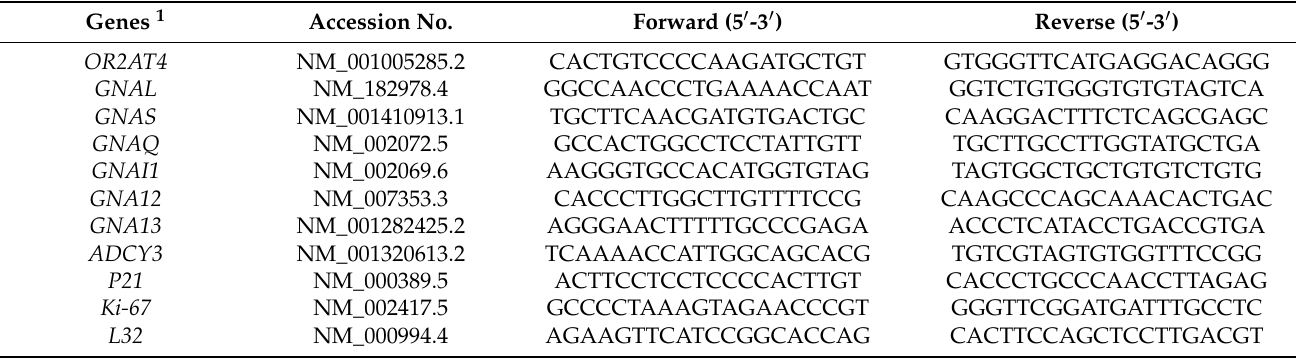
Table 1. Primer sequences used for real-time quantitative